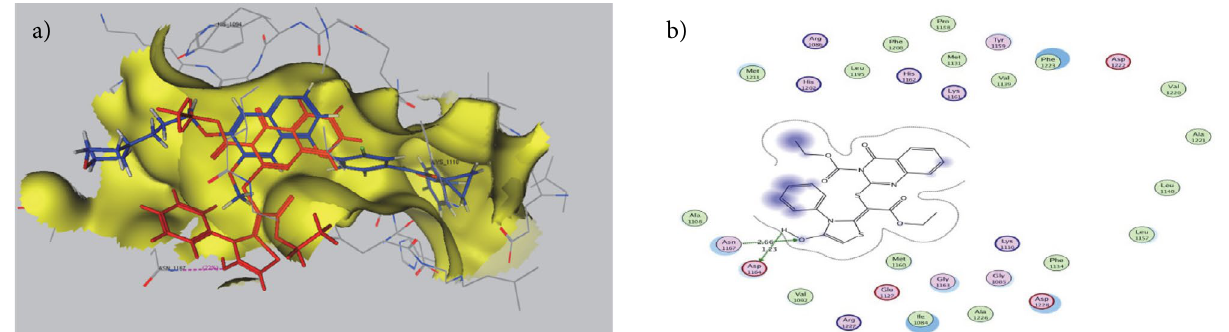
Figure 5. (a) The superposition of foretinib (blue) and compound 24a (red) docked in the binding site of c-Met, the dotted lines represent H-bond- ing interactions; (b) 2D ligand interaction of 24a in binding site of c-Met.